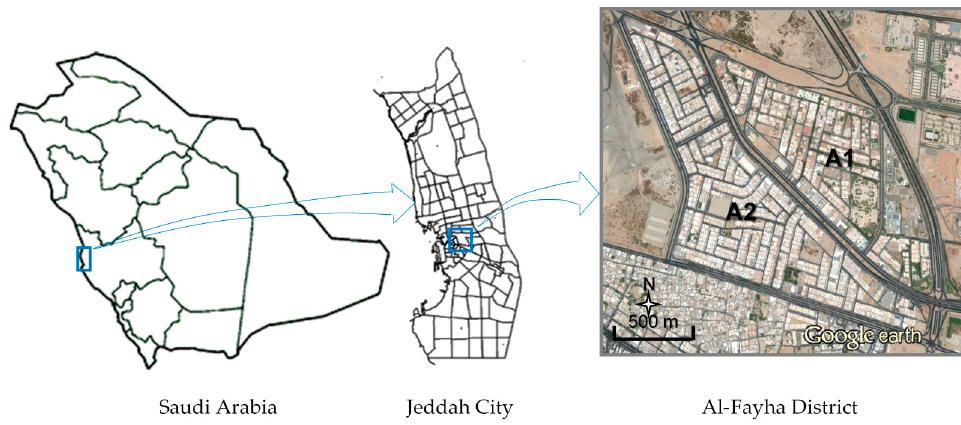
Figure 1. Study area (Al-Fayha District).